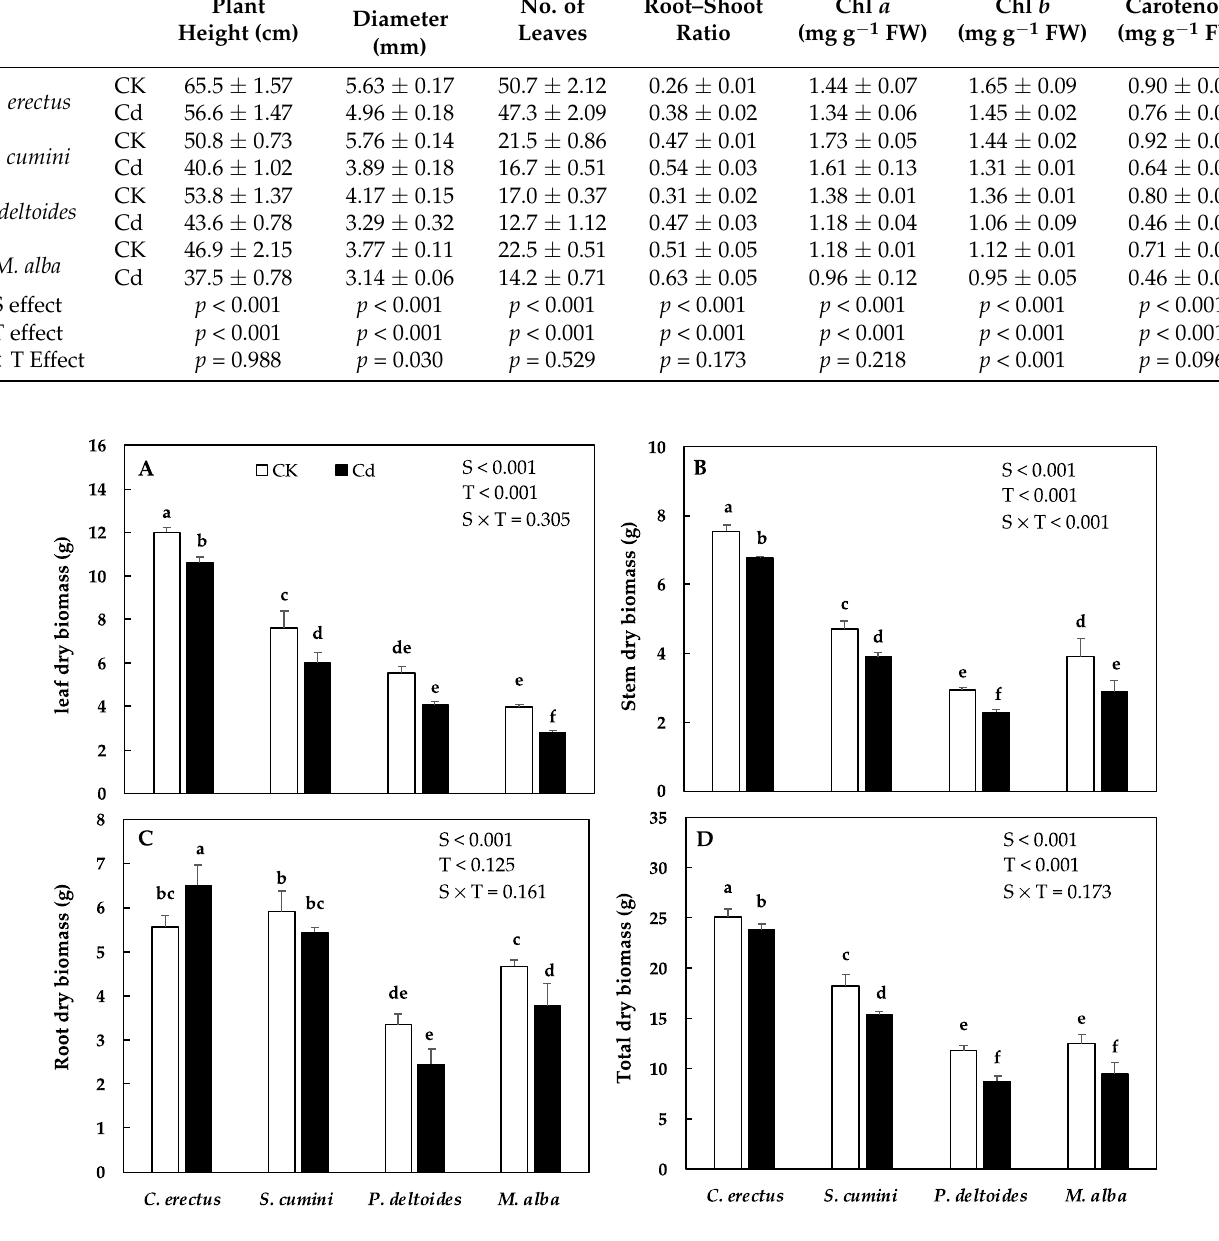
Table 1. Means ± SE for growth traits and chl a, b and carotenoid contents in four tree species under CK and Cd treatments. Small letters depict significant differences between treatment means (n = 5). Plant Height (cm)